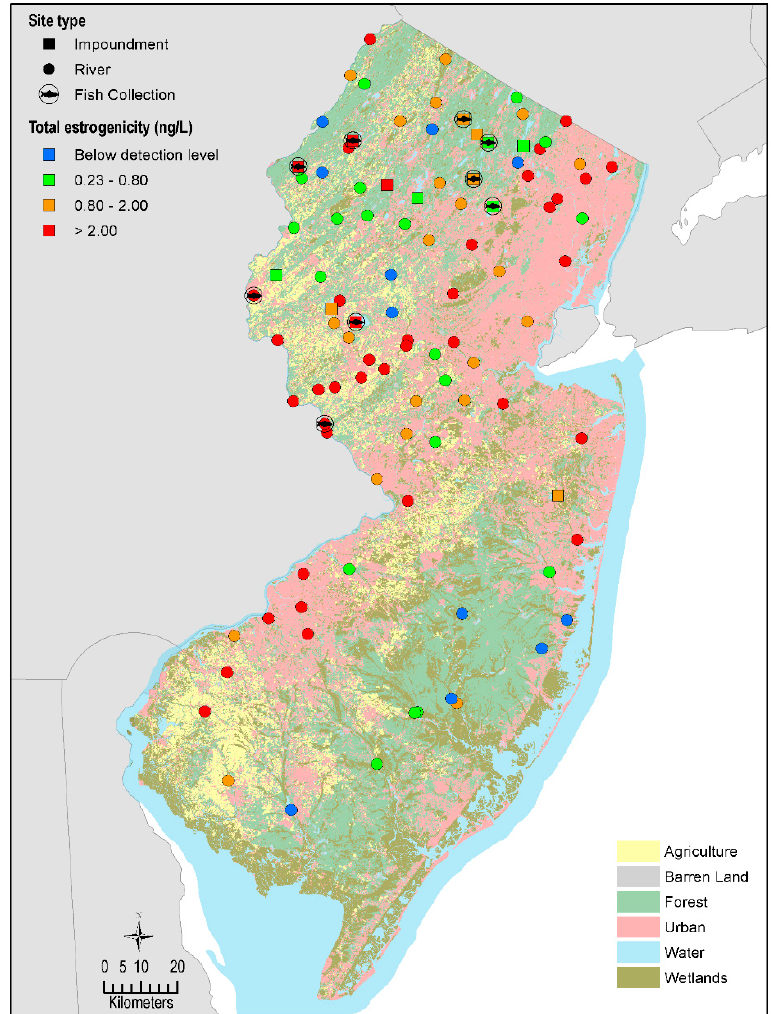
Figure 1. Surface water and fish sampling locations throughout New Jersey. Ranges of total estrogenicity (ng / L E2Eq BLYES ) are binned as below detection (BD), low (0.23–0.80), medium (0.80–2.00) and high ( > 2.00). Values are those from the fall 2016 sampling. Dominant land-use designations are colormetrically depicted across the landscape.